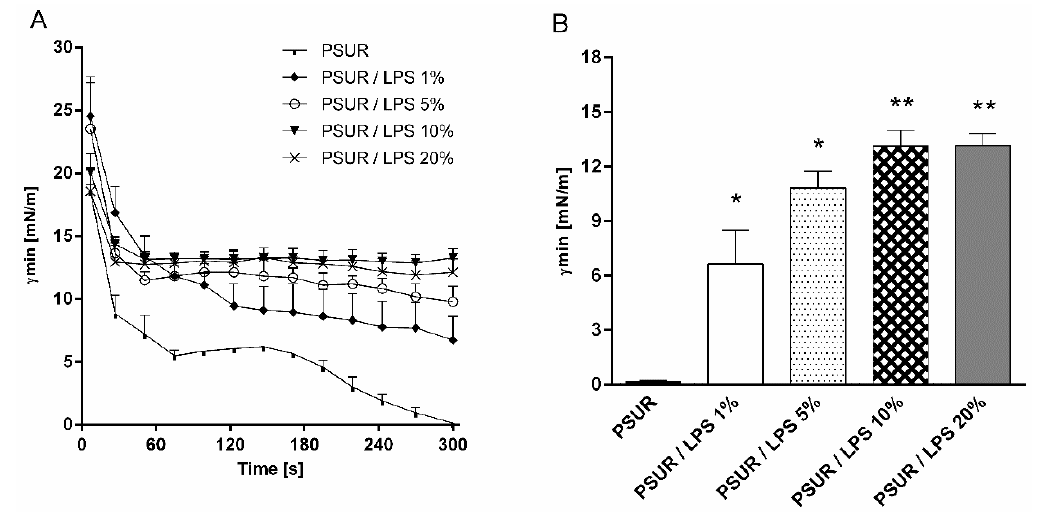
Figure 1. Minimum surface tension ( γ min ) of modified porcine surfactant (PSUR) at phospholipid concentration of 1.75 mg/mL without or with lipopolysaccharide (LPS) at 1%, 5%, 10%, and 20% ( w / w ) during the whole period of pulsation ( A ), and at fifth minute of pulsation ( B ) in pulsating bubble surfactometer. Values are given as means ± SEM. PSUR vs. PSUR/LPS: * p < 0.05 and ** p < 0.01.